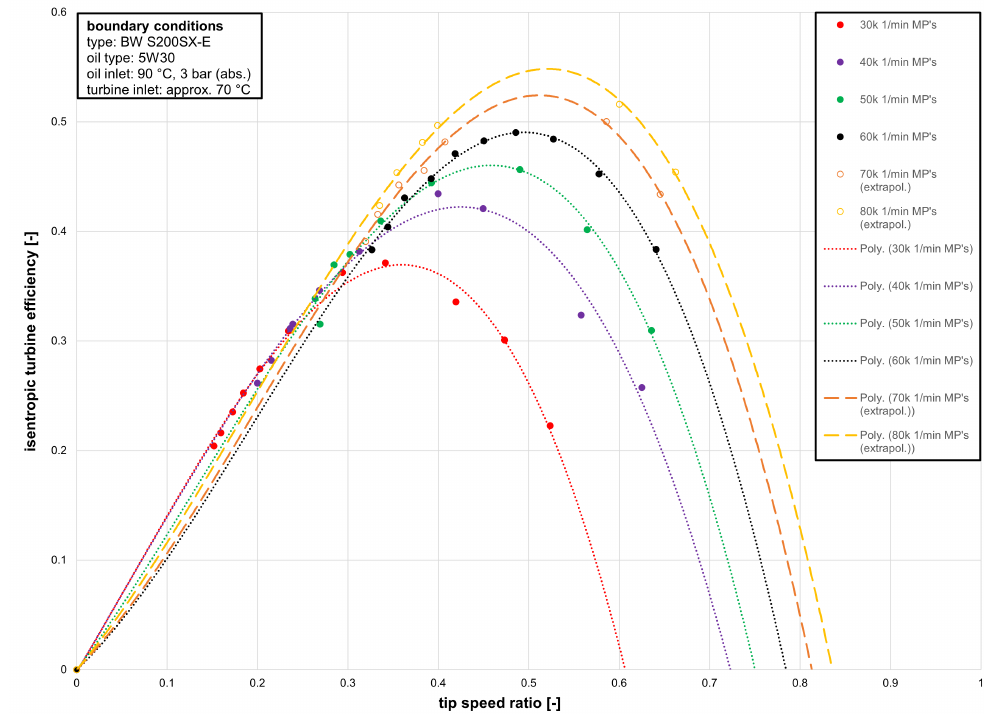
Figure 13. HGTB–tip speed ratio over isentropic turbine efficiency with adapted turbine components of an